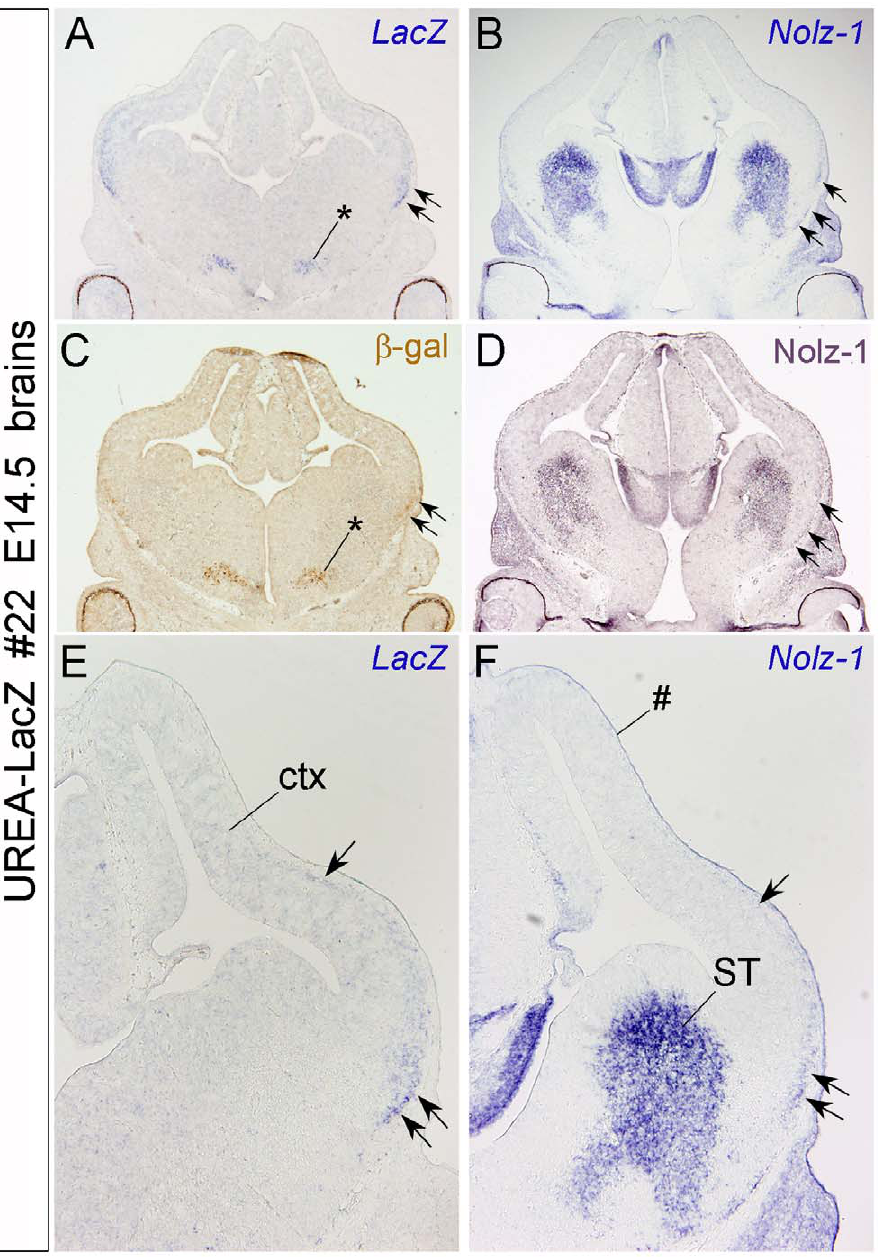
Figure 6. Detection of LacZ and Nolz-1 mRNA expression in the ventrolateral cortex of E14.5 line # 22 UREA-LacZ brain. A–D: Expression of LacZ mRNA (A), Nolz-1 mRNA (B), b -gal (C) and Nolz-1 protein (D) in coronal forebrain sections. Expressions of LacZ mRNA and b -gal protein are detected in a domain of ventral forebrain (asterisk, C) and in a strip of lateral cortex (ctx, double arrows in A, C and arrows in E). Nolz-1 mRNA is also expressed in a similar lateral strip in cortex (arrows in B, D, F). Note that, more LacZ - and Nolz-1 -expressing cells are present in the ventral part (double arrows, E, F) than in the dorsal part (single arrow, F) of the strip. ST, striatum. # indicates non-specific staining of meninges.